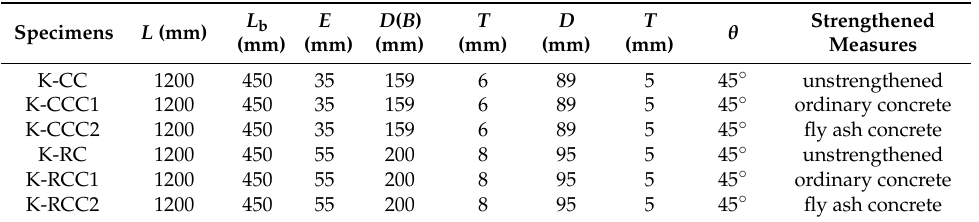
Table 1. Geometric parameters of specimens.